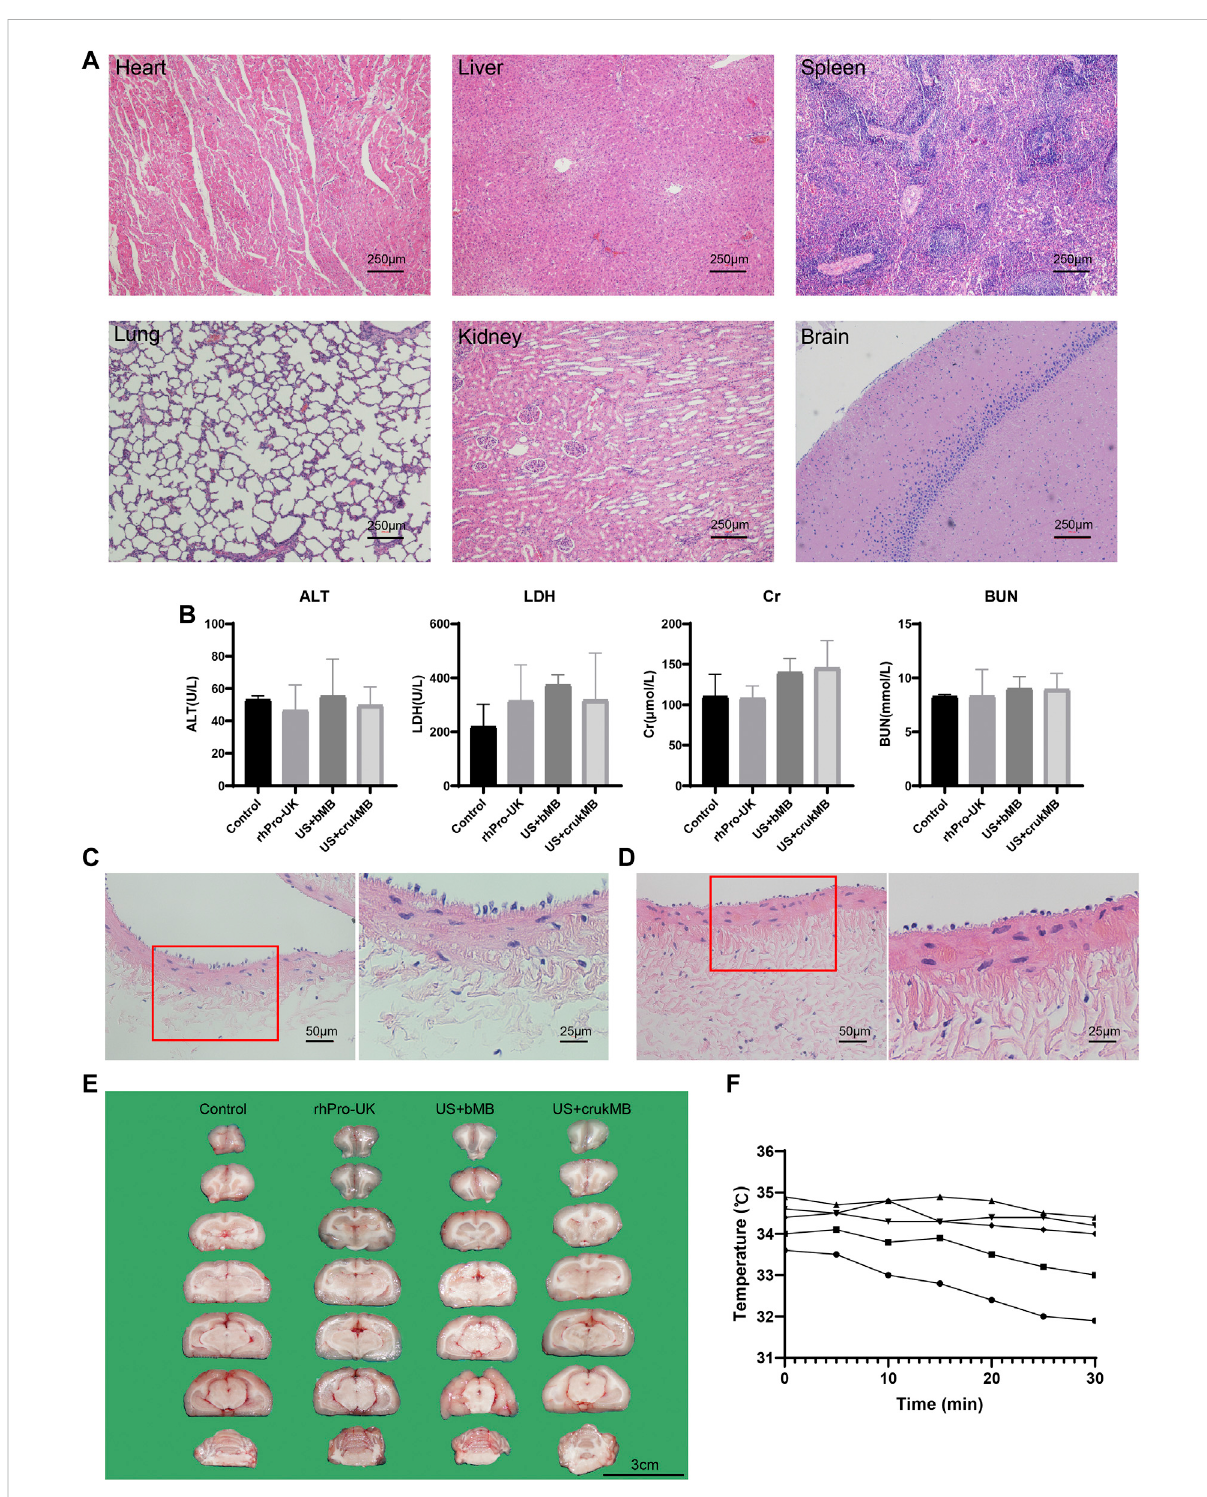
Safety evaluation. (A) Major organs (heart, liver, spleen, lung, kidney and brain) were harvsted for histological evaluation. No pathological founding was identi fi ed. (scale bars, 250 μ m) (B) No difference was identi fi ed in the level of serum alanine aminotransferase (ALT), lactate dehydrogenase (LDH), creatinine (Cr), blood urea nitrogen (BUN). ( n = 3 – 5) The lining of endothelia was comparable in vessels without (C) and with ultrasonicexposure (D) , respectively. (scale bars, 50 μ m, 25 μ m) (E) No hemorrhagewas identi fi edin theUS + crukMB group. (scale bars, 3